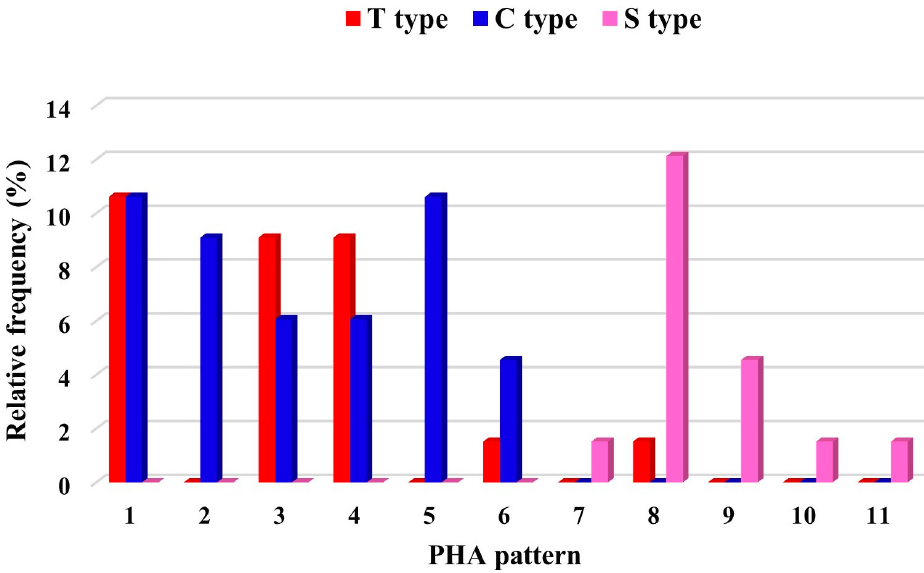
Figure 2. Frequency distribution of PHA patterns in relationship with PHAS types in the landrace collection from the Lazio region.